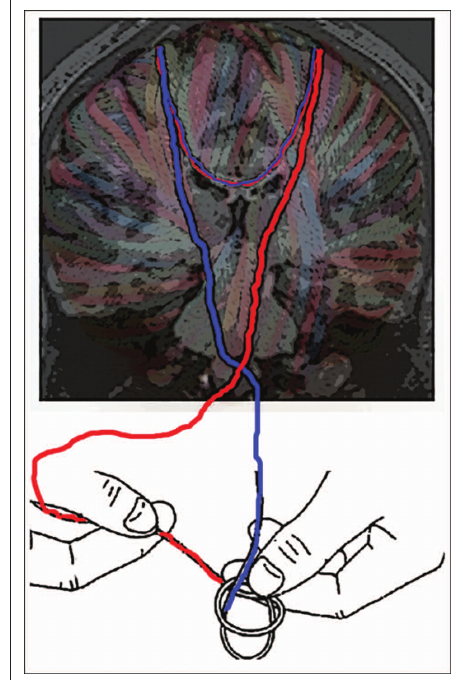
Figure 1 | The brain’s white matter is conceptualized as yarn in this diagram. The descending strands represent corticospinal control of each hand by its respective contralateral motor cortex. The callosal strands represent the capacity for interhemispheric interactions. In an asynchronous bimanual task such as shoe tying, interhemispheric inhibition is relied upon to prevent interference between control processes for the two hands. At the same time, interhemispheric facilitation may be relied upon to integrate actions of the two hands, allowing them to achieve a single unified